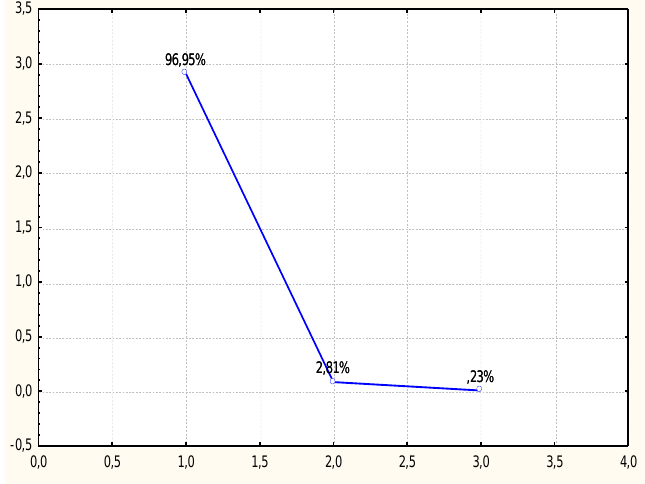
Figure 5. Screen for variables describing the changes in the concentration of ethyl alcohol after